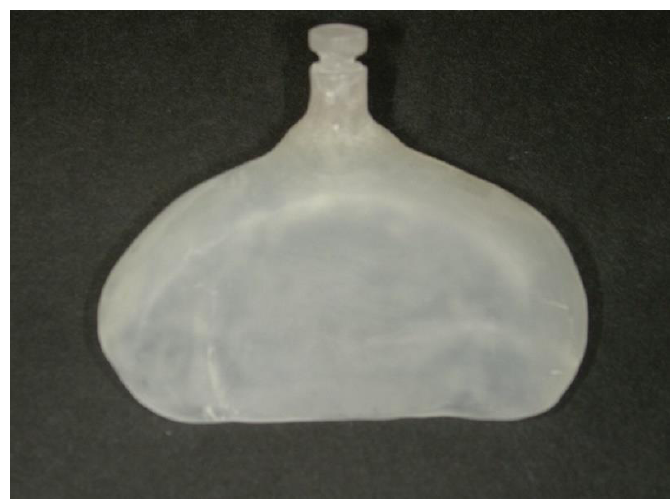
Figure 3. Molding plate used for preoperative orthognathic treatment.